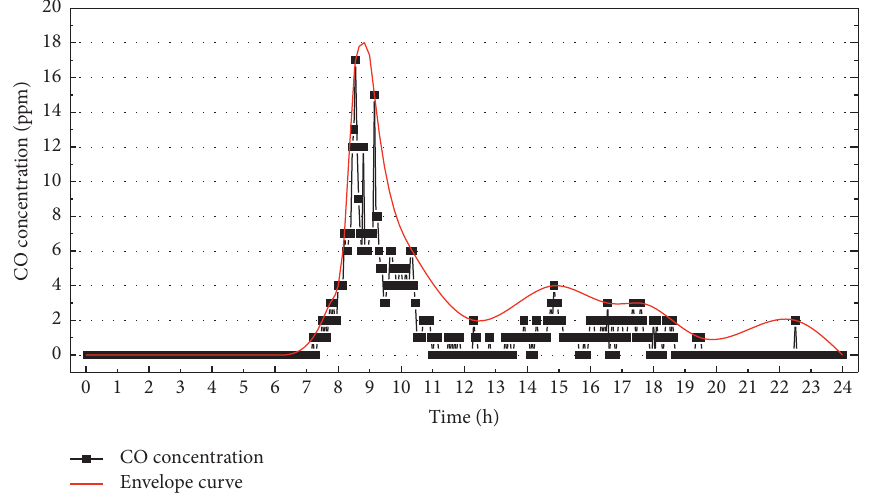
Figure 8: Diurnal profile of CO concentration in the left bore of Henglongshan Tunnel